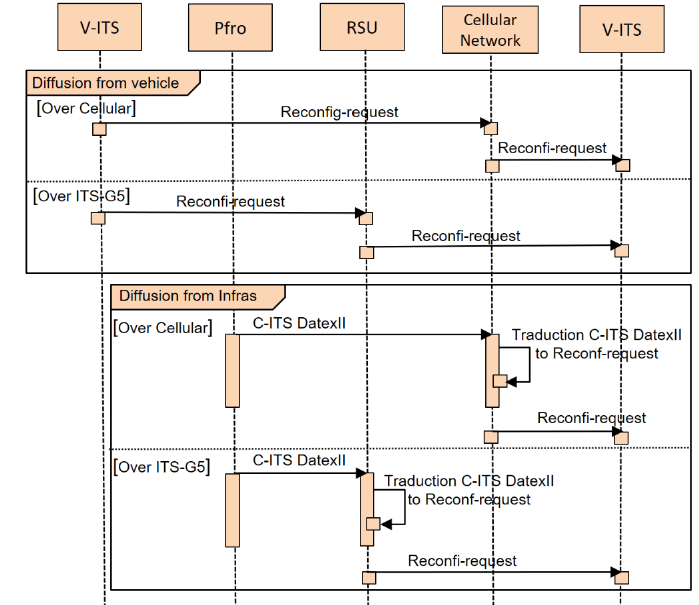
Figure 18. Sequence diagram for reconfiguration diffusion from a vehicle and